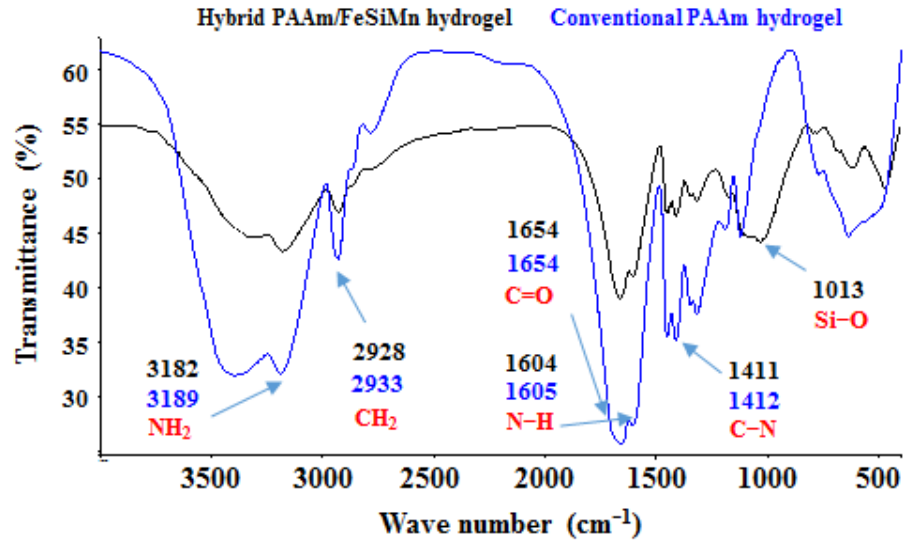
Figure 12. FTIR spectra for polyacrylamide and polyacrylamide/FeSiMn hydrogels (%FeSiMn = 10).